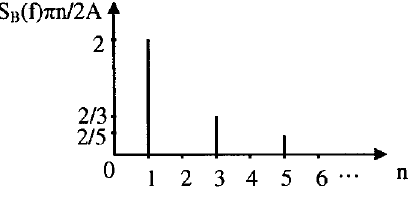
FIGURE 19 Power spectral density of the periodic binary